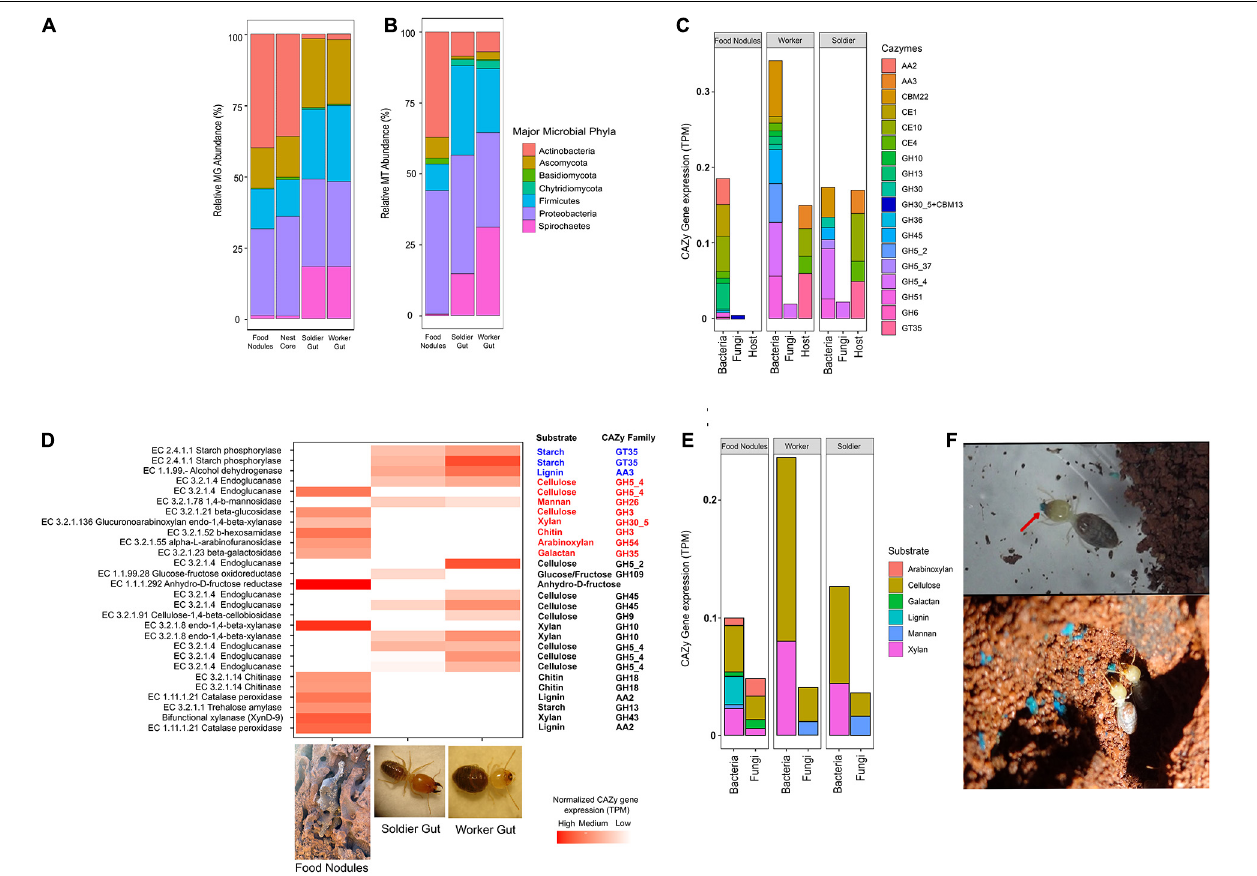
FIGURE 3 | (A) Relative metagenomic (MG) and (B) metatranscriptomic (MT) abundance assigned to major phyla in C . cumulans . (C) Contribution of the termite holobiont (gut, nest microbiota and host) to CAZy expression. (D) Complementary CAZy gene expression and lignocellulolytic activity in food nodules and gut of workers and soldiers. The heatmap shows normalized expressions of protein coding genes of major CAZy families colored according to taxonomy assignment (Blue: termite host; Red: fungi; Black: bacteria). (E) CAZy gene expressions predicted for lignocellulosic substrates in food nodules and gut of workers and soldiers. (F) Detail of the food storage behavior of C . cumulans workers on the nest walls using blue-marked sugar-cane (red arrow).